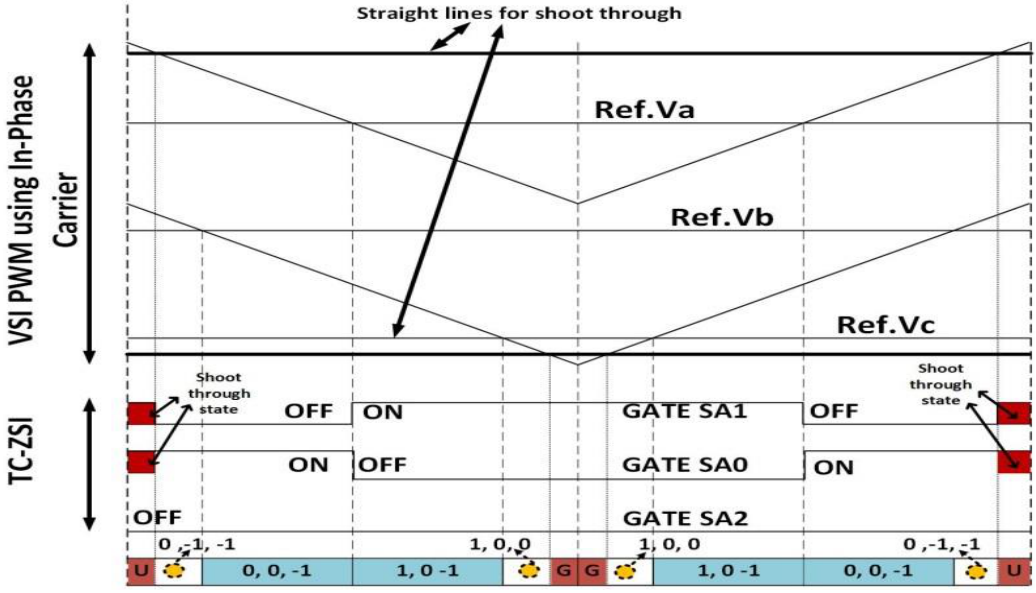
Figure 10. Description of shoot-through for TC-ZSI.